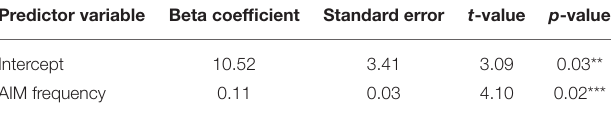
TABLE 2 | Model 1: linear regression of family life and AIM frequency.